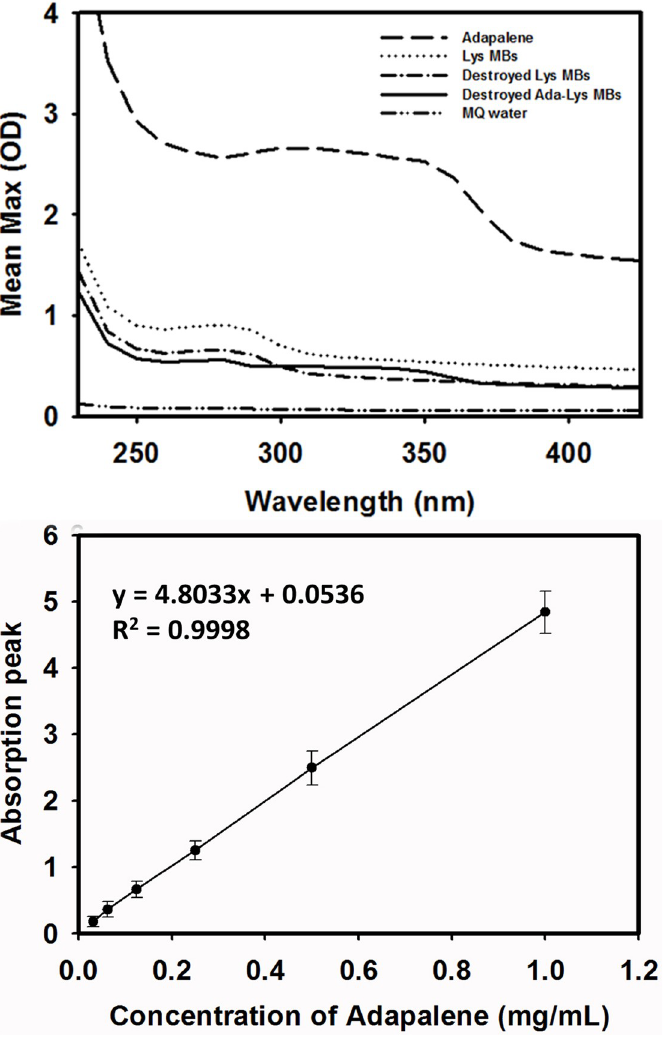
Fig 3. (A) Absorbance spectra of the indicated solutions, (B) Ada standard calibration curve used to determine the concentrations of samples.